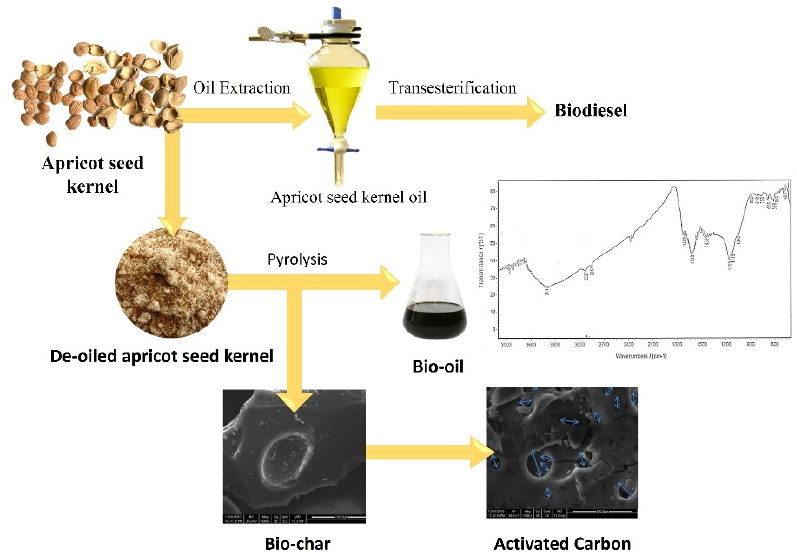
Figure 8. Production process of biofuel and activated carbon from apricot seed kernel [68].